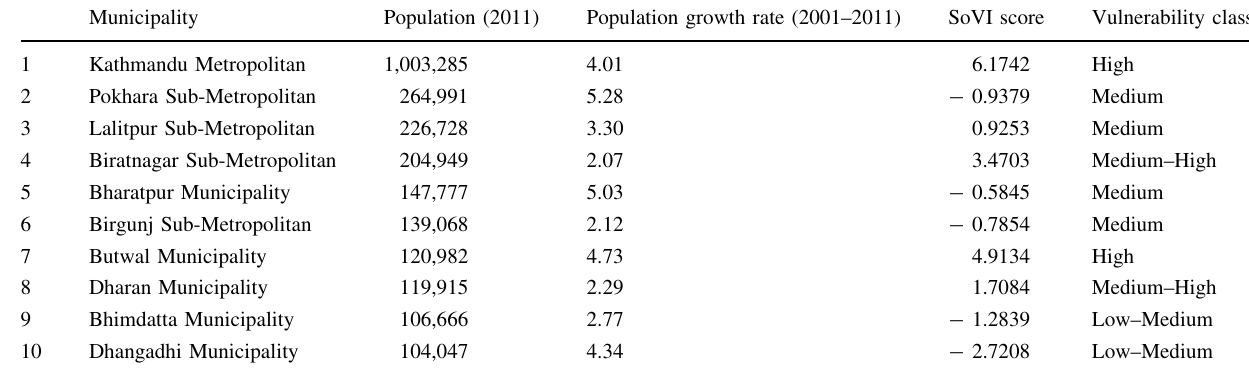
Table 3 Level of social vulnerability of Nepal’s 10 largest